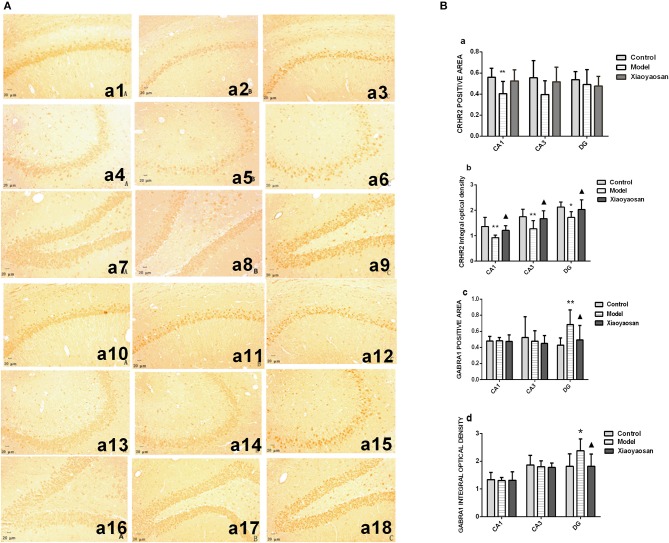
Effects of Xiaoyaosan on the expression of the CRHR2 and GABRA1 mRNAs in the rat hippocampus. (A) The expression of the CRHR2 and GABRA1 mRNAs in the hippocampal CA1, CA3 and DG regions. The expression of the CRHR2 mRNA in the hippocampal CA1
(a1–a3), CA3 (a4–a6), DG (a7–a9) regions of the control, model, and Xiaoyaosan groups is shown. The expression of the GABRA1 mRNA in the hippocampal CA1
(a10–a12), CA3 (a13–a15), DG (a16–a18) regions of the control, model, Xiaoyaosan groups is shown. (B) Changes in the expression of the CRHR2 and GABRA1 mRNAs in the rat hippocampus. (a) CRHR2-positive area in ISH. (b) Integrated optical density of the ISH for CRHR2. (c) GABRA1-positive area in ISH. (d) Integrated optical density of the GABRA1 ISH. Values are presented as the means ± SD from 10 rats per group. *P < 0.05 and **P < 0.01 compared with the control group. ▴P < 0.05 compared with the model group.